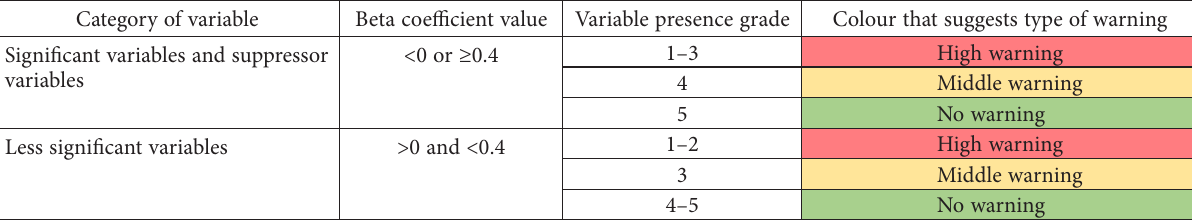
Table 3. Visuals of early